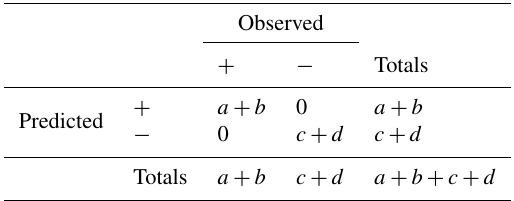
Table 4. Omnipotent forecaster’s score relative to Table 2’s data on prediction.